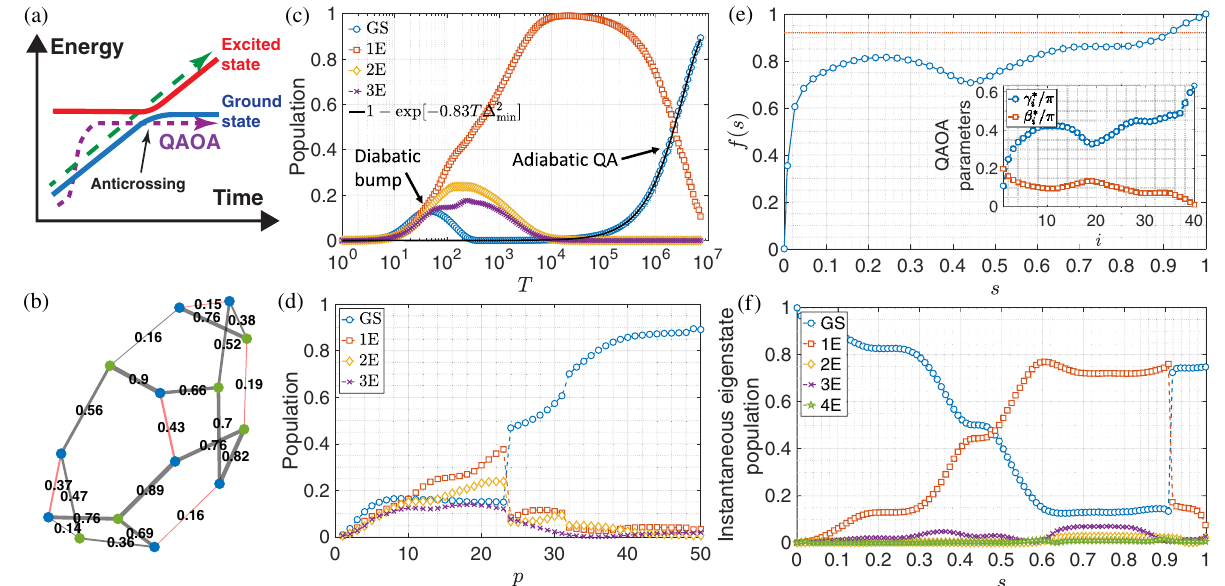
FIG. 6. (a) A schematic of how the QAOA and the interpolated annealing path can overcome the small minimum gap limitations via diabatic transitions (purple line). A naive adiabatic quantum annealing path leads to excited states passing through the anticrossing point (green line). (b) An instance of a weighted 3-regular graph that has a small minimum spectral gap along the quantum annealing path given by Eq. (9). The optimal MaxCut configuration is shown with two vertex colors, and the black (red) lines are the cut (uncut) edges. (c) Population in low-energy states after the quantum annealing protocol with different total times T . The black solid line follows the 1 − exp ð − cT Δ 2 Landau-Zener formula for the ground state population, p Þ , where c is a fitting parameter. (d) Population in low- GS ¼ min energy states using the QAOA at different levels p . The FOURIER heuristic strategy is used in the optimization. (e) Interpreting QAOA parameters (at p ¼ 40 ) as a smooth quantum annealing path, via linear interpolation according to Eq. (14). The annealing time P p γ (cid:3) β (cid:3) parameter s ¼ t=T p , where T p ¼ i j þ j i jÞ . The red dotted line labels the location of anticrossing where the gap is at its i ¼ 1 ðj minimum, at which point f ð s Þ ≈ 0 . 92 . The inset shows the original QAOA optimal parameters γ (cid:3) i and β (cid:3) i for p ¼ 40 . (f) Instantaneous eigenstate population under the annealing path given in (e). Note that the instantaneous ground state and first excited state swap at the anticrossing